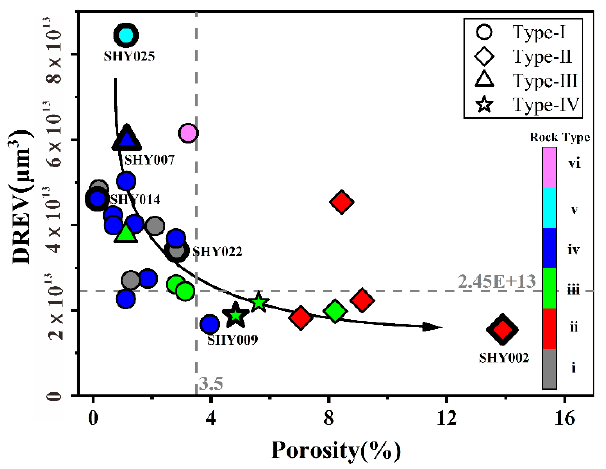
Figure 14. Cross ‐ plot of DREV versus CREV. Figure 15. Cross ‐ plot of porosity and DREV with rock type superimposed in color. Marker shape represents pore type.